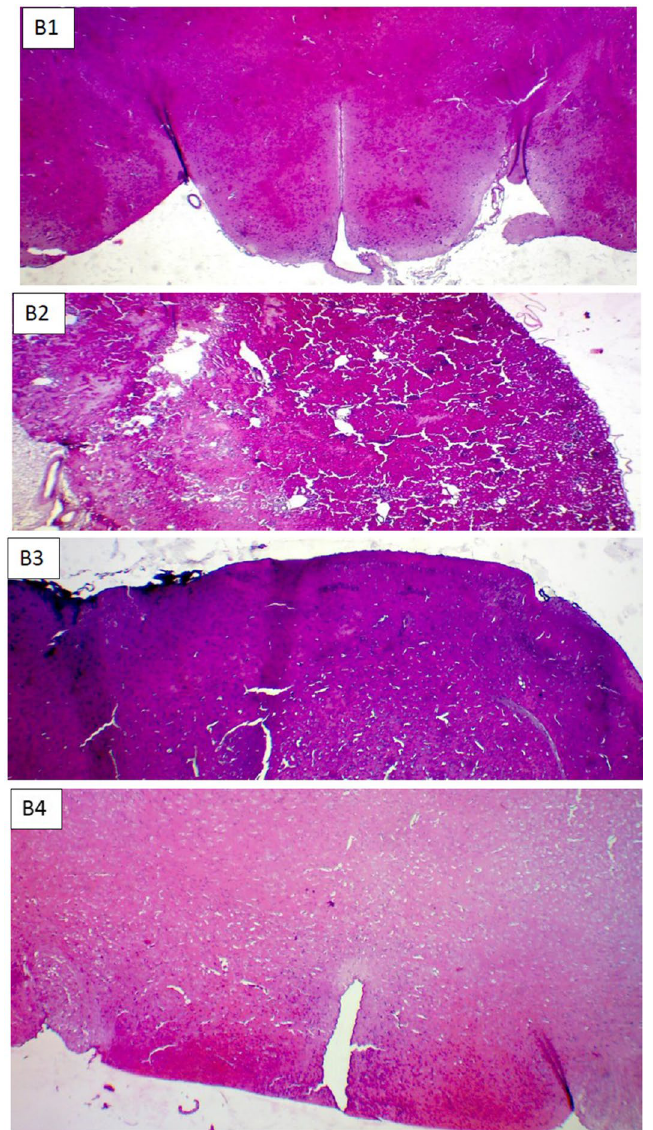
Figure 5. H&E stained pathological samples of Brain in: (B1) non-EAE group, (B2) EAE group, (B3) EAE-GA group, (B4) EAE-GA/Depot